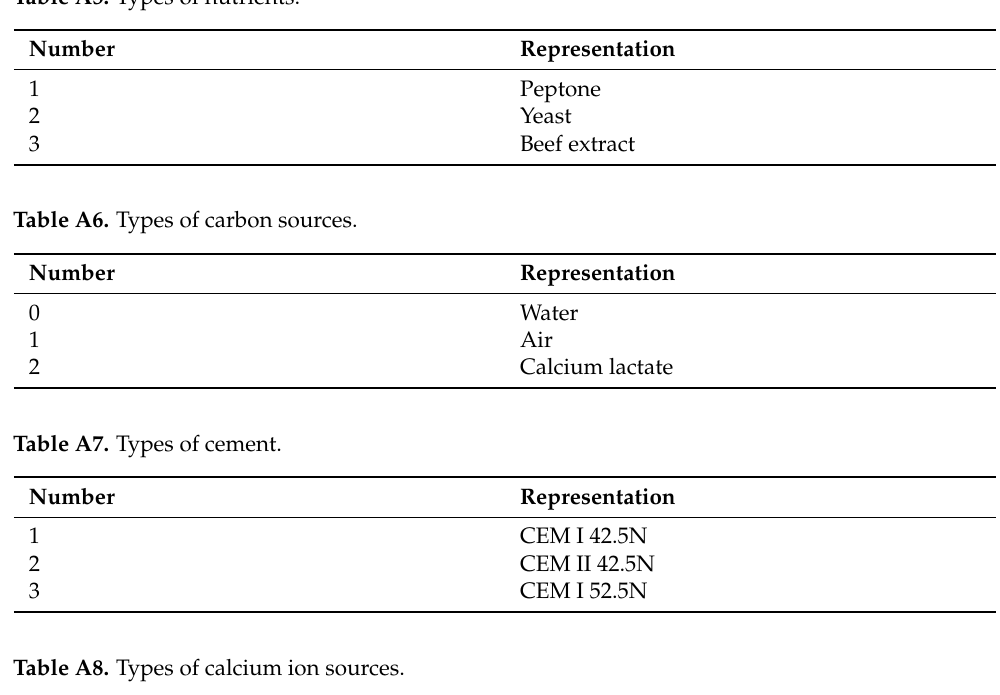
Table A5. Types of nutrients.